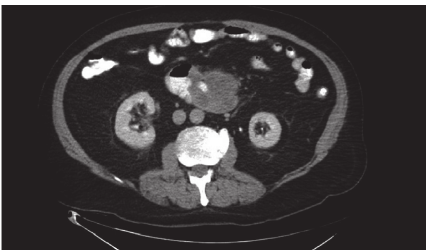
Figure 1: Initial CT scan showing mass in the duodenum.